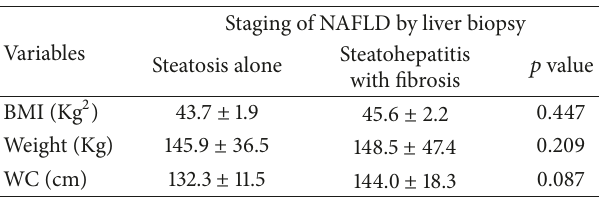
Table 5: Mean/deviation of anthropometric variables according to the staging of NAFLD.